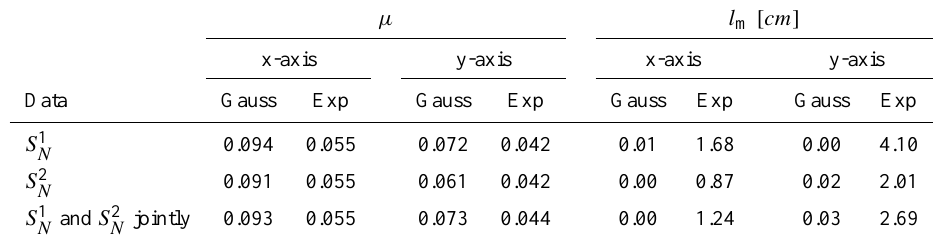
Table 2. Multiple faces data. Estimates of µ = λ u / L and the associated support scale l m .